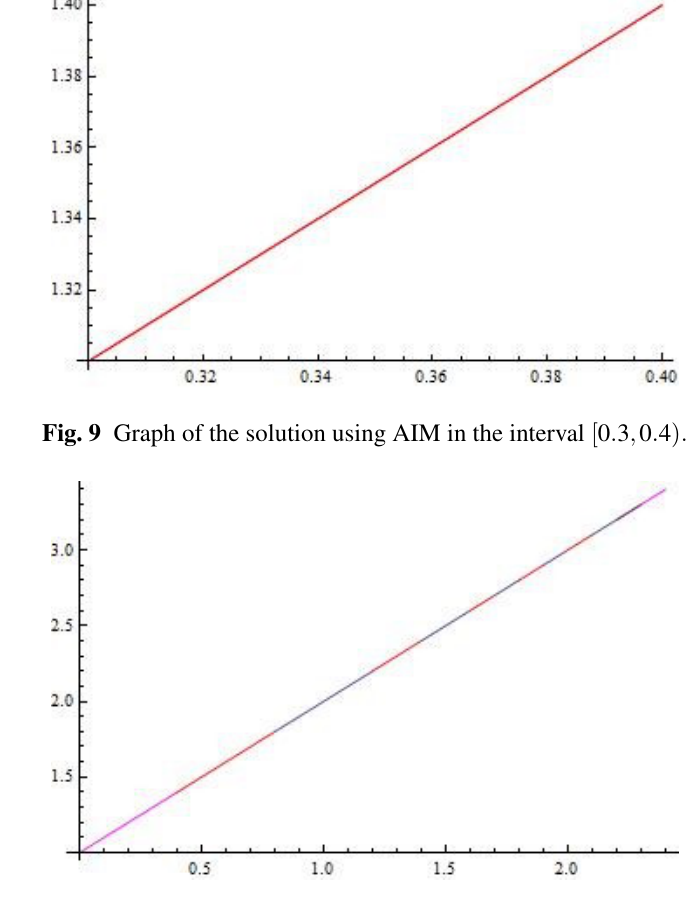
Fig. 10 Graph of the solution using MMIM for the interval [ 0 , 2 ]